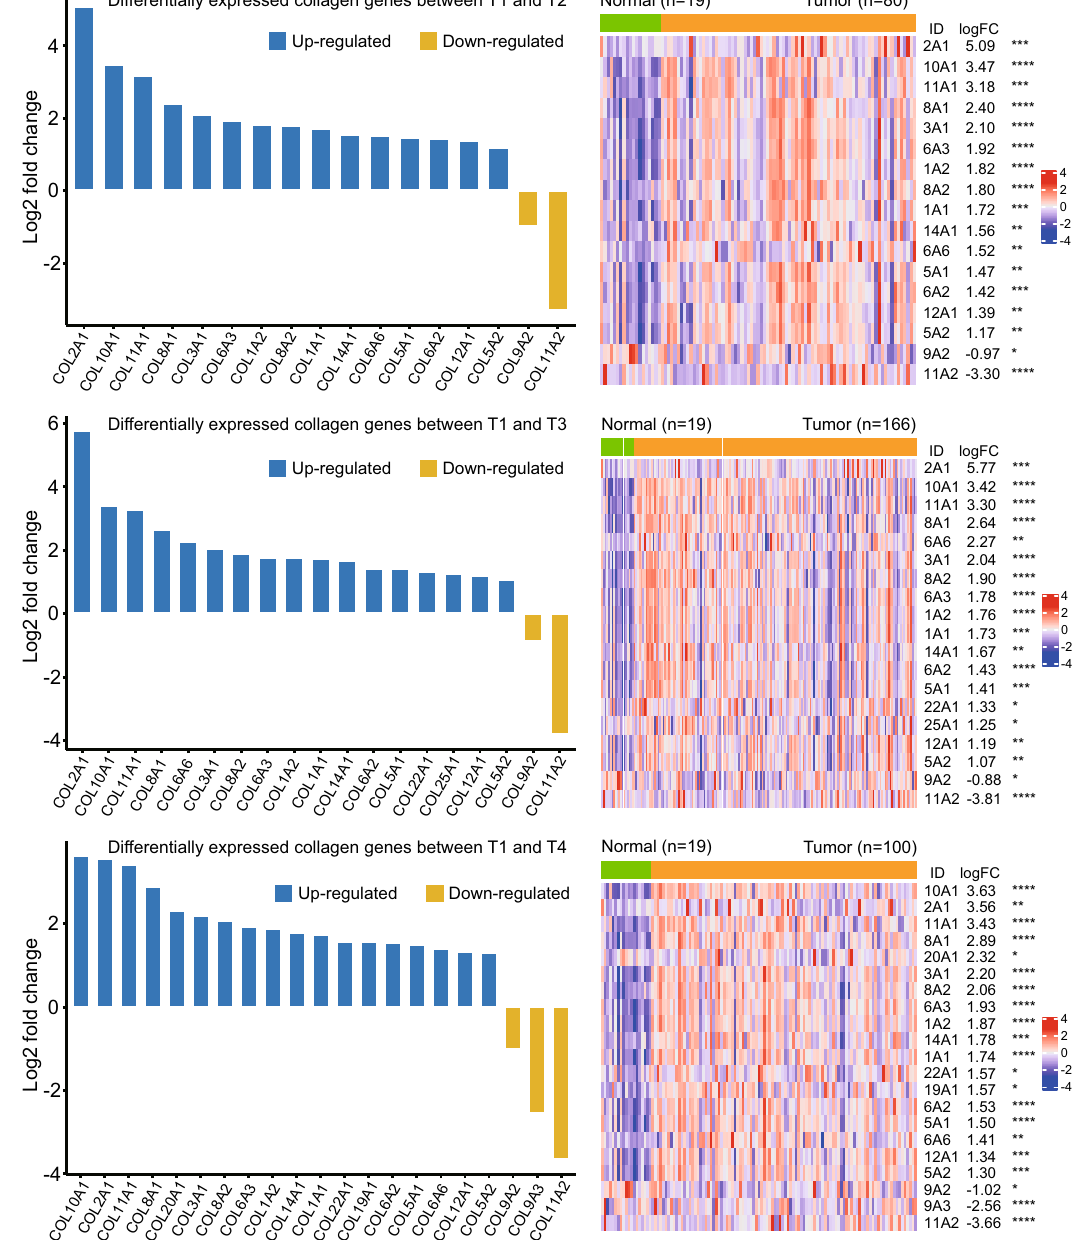
Figure 3. Differentially expressed collagen genes between T1 and other three T stages. Samples of the T1 stage were served as control group for all the differential expression